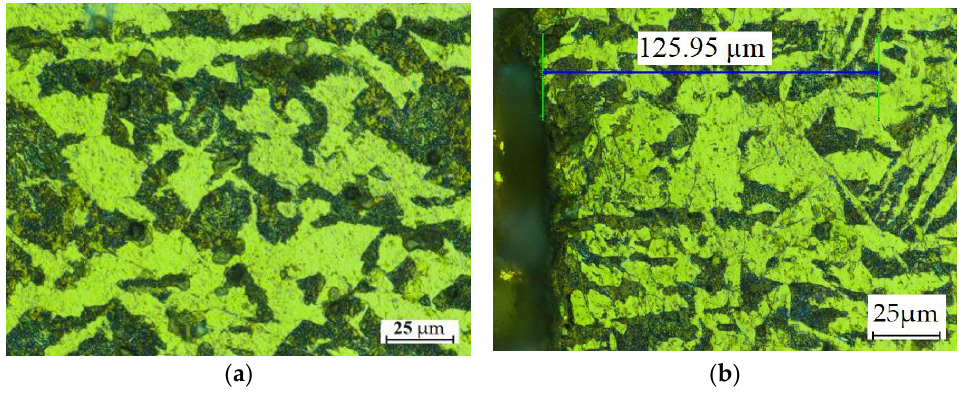
Figure 6. Microstructure of the hot rolled steel ( a ) before and ( b ) after the AWJM process. After the cutting, the material close to and along the edge had a fine-grained microstructure with smaller ferrite subgrains. A large number of such subgrains formed in the ferrite grains, as shown in Figure 6. The formation of the fine-grained structure, observed up to about 40 µm from the line of cut, was due to the occurrence of temperatures higher than the eutectoid temperature. After cutting with an abrasive water jet, the partially strand-like pattern of dark grains of pearlite and light grains of ferrite is no longer present. At larger distances, i.e., 50–150 µ m from the line of cut, the average size of ferrite grains increases.